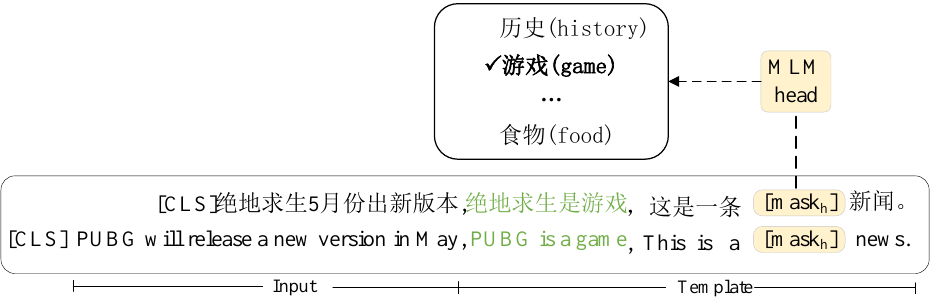
Figure 3. The prompt-based text classification model with knowledge